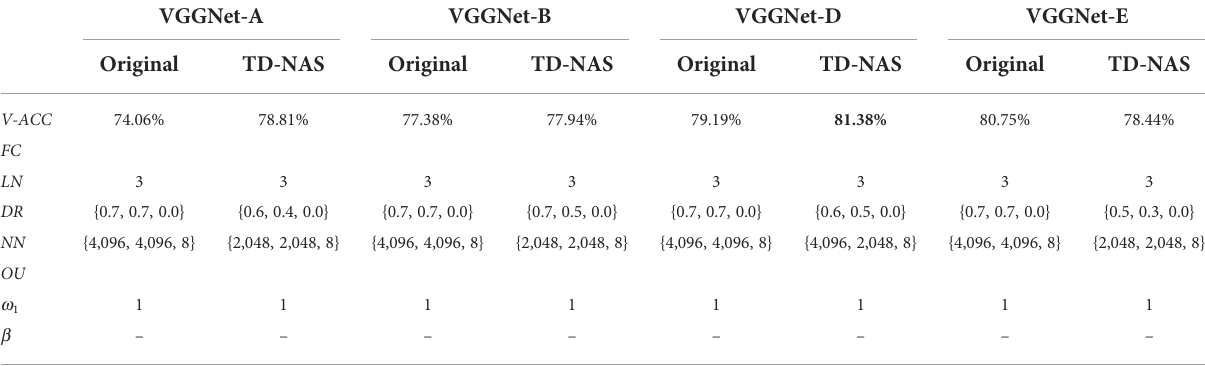
TABLE 2 TD-NAS and original VGGNet (A, B, D, and E) ( RSDS-0.1K , w 1 =